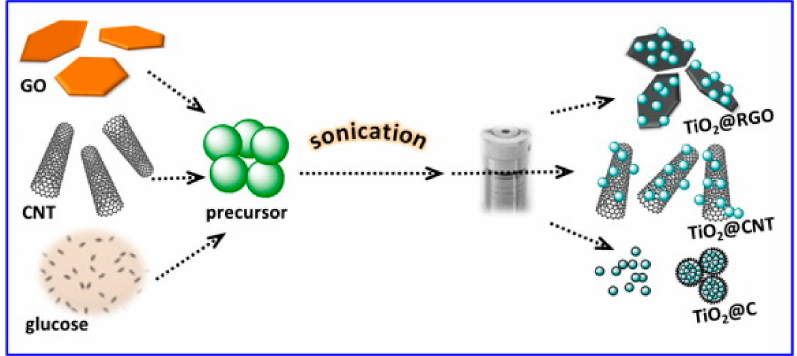
Figure 9. Schematic illustration of the preparation method to obtain carbon-based / TiO 2 nanohybrids. Adapted and reprinted with permission from [164], Copyright (2016)